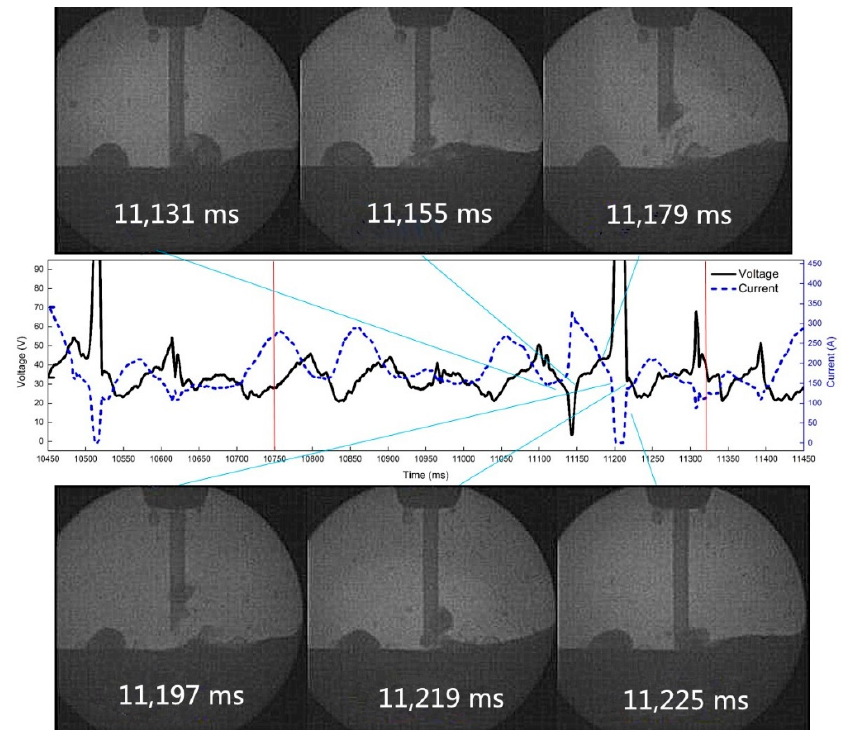
Figure 18. The arc extinguishing process of droplet reburning at 10 Hz and 0.5 mm withdrawal quantity.